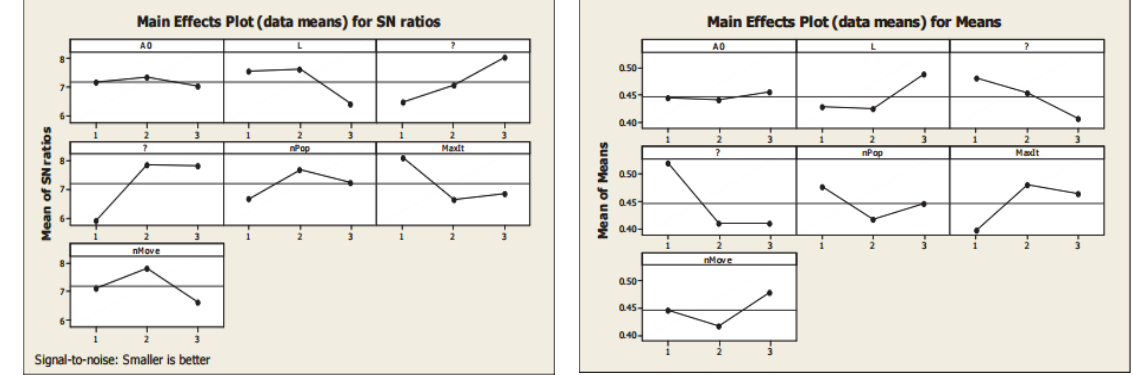
Fig. 6. The results of Taguchi